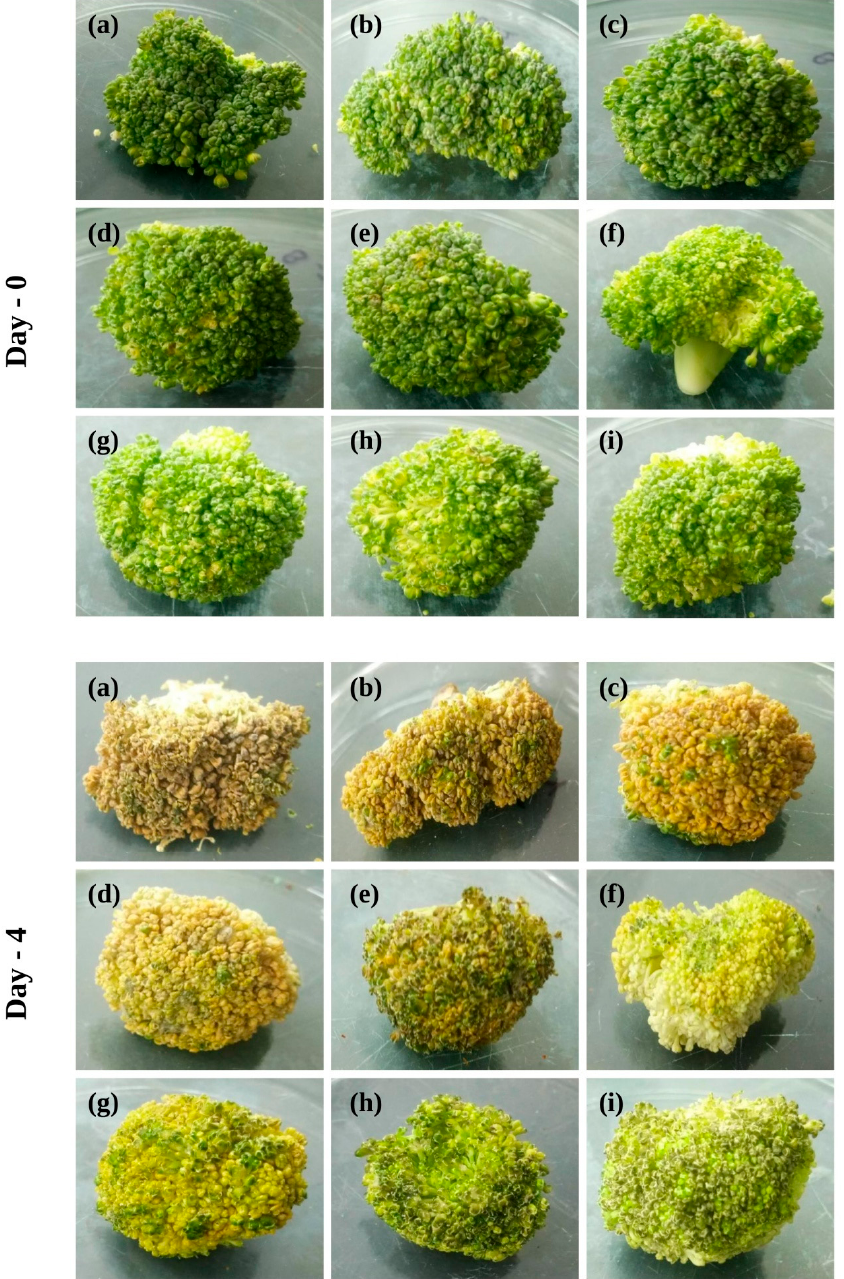
Figure 9. Broccoli florets after being stored for 4 days. ( a ) Broccoli florets stored directly; ( b ) Ch film; ( c ) Ch/HNTs—5% ( d ) Ch/HNTs—15%; ( e ) Ch/HNT—30%; ( f ) Ch/BEO; ( g ) Ch/BEO/HNTs—5%; ( h ) Ch/BEO/HNTs—15%; ( i ) Ch/BEO/HNTs—30%.